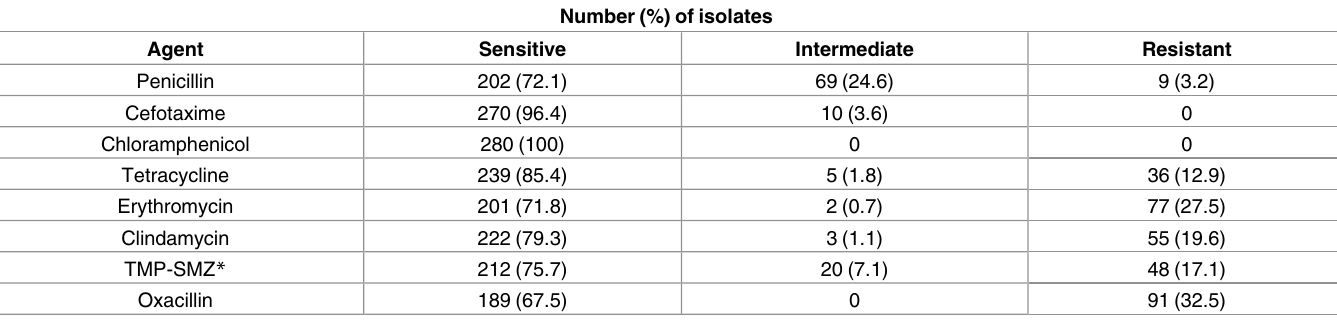
Table 4. Antimicrobial susceptibility of the 280